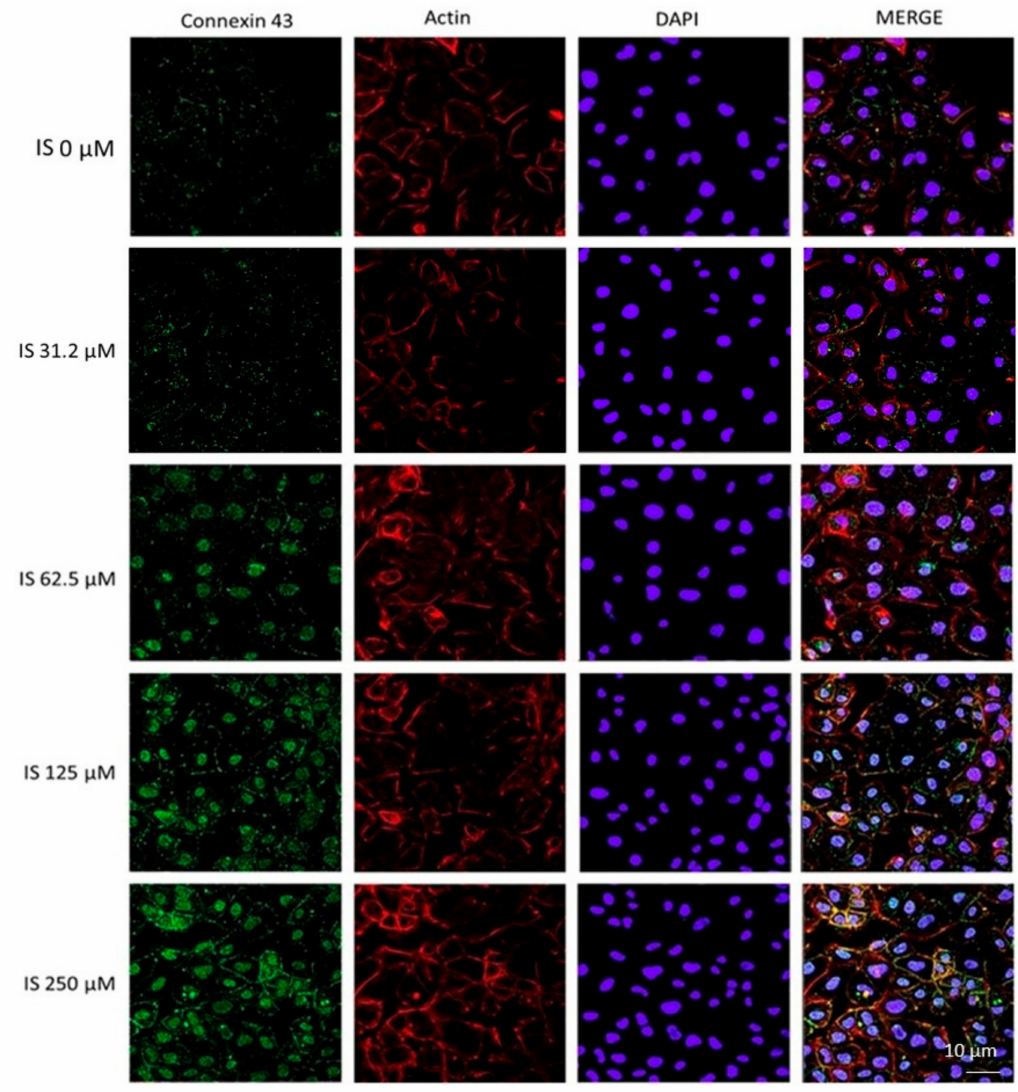
Figure 5. E ff ect of IS (31.2–250 µ M) on connexin 43 expression in IEC-6 cells. Immunofluorescence analysis was performed by a immunofluorescence confocal microscopy ( n = 15). Scale bar, 10 µ m. Blue fluorescence indicated the localization of nuclei (DAPI), green indicated the localization of connexin 43 and red indicated the localization of actin